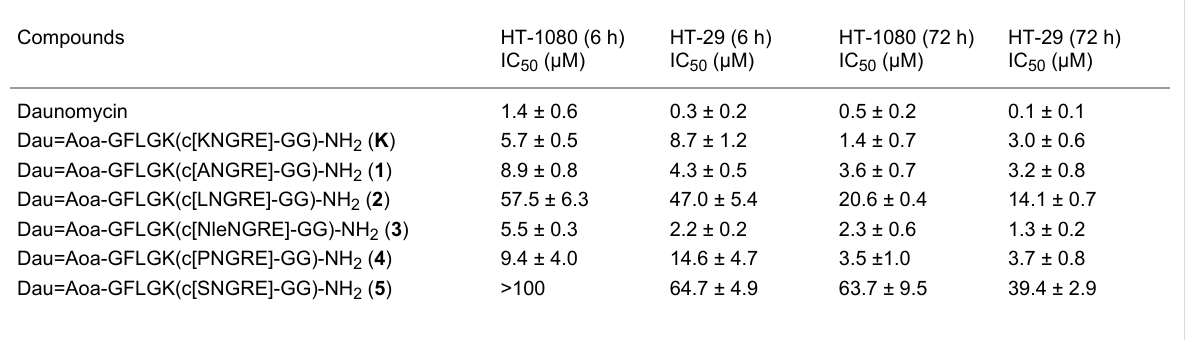
Table 3: In vitro cytostatic/cytotoxic effects of compounds on HT-29 and HT-1080 cells.